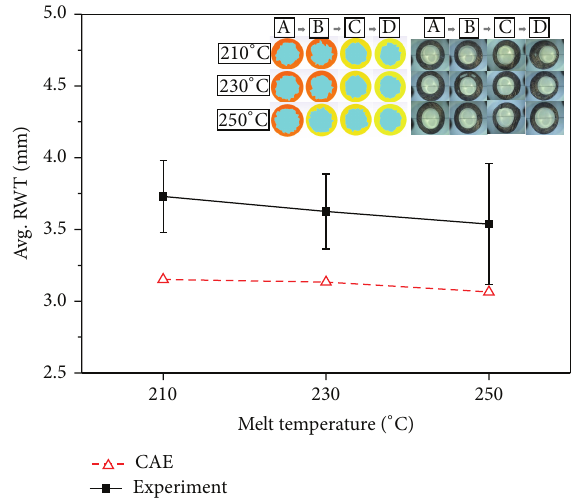
Figure12:Effectofwaterpressureonaverageresidualwallthickness for the experiment and analysis results.